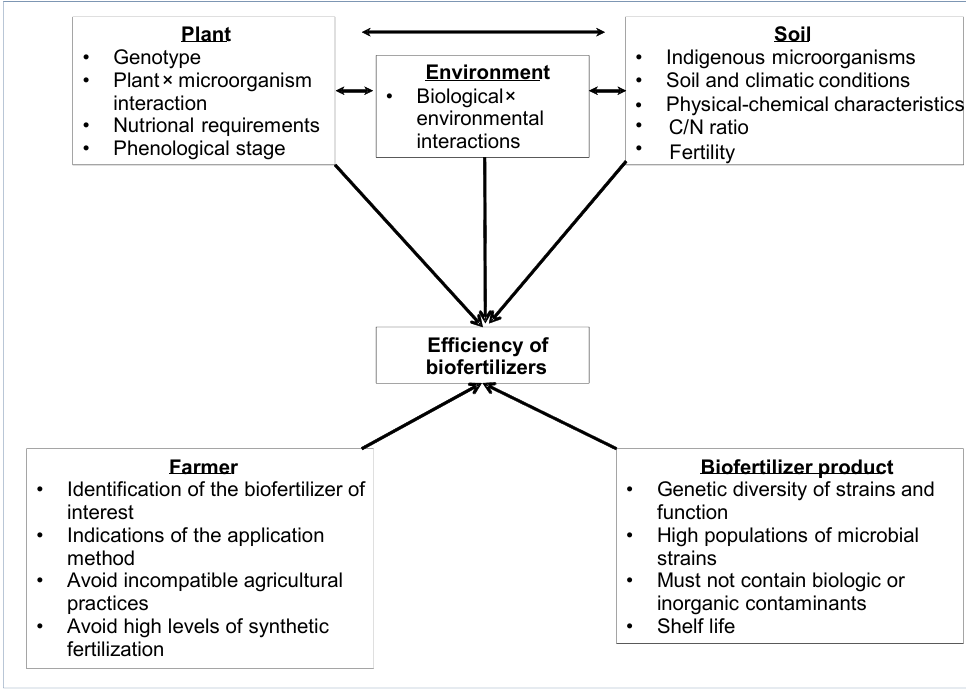
Figure 2. Considerations for successful use of biofertilizers in agriculture. Adapted from Chávez-Diaz et al. [1].